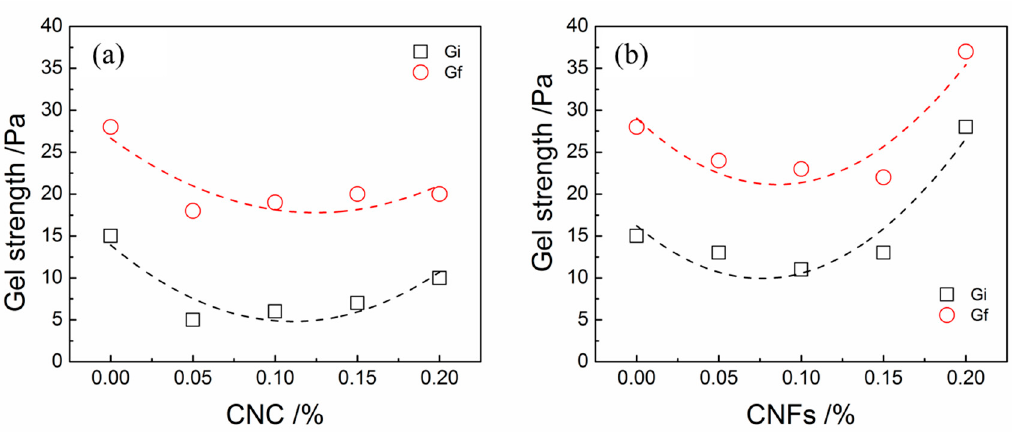
Figure 6. Plots of initial and final gel strengths as a function of CNP content: ( a ) CNC-OWC; ( b ) CNF-OWC .